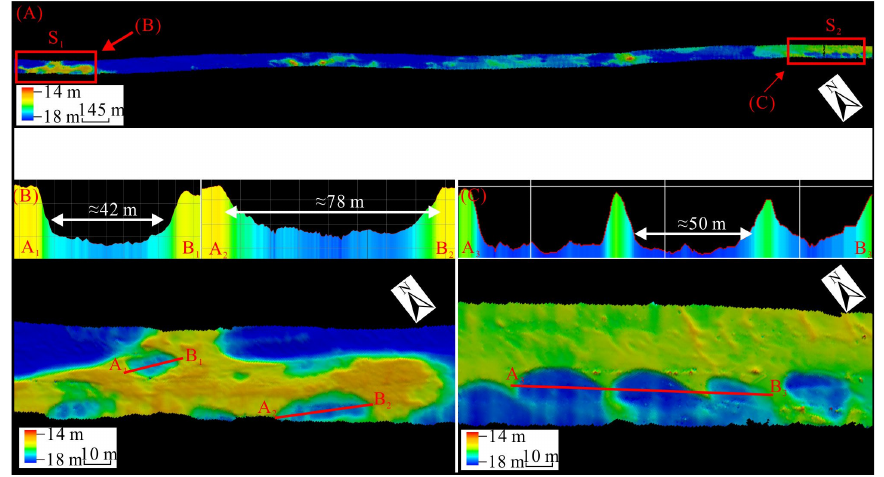
Figure 7. Diagram of the sand mining in the SC of the Yangtze River Estuary. ( A ) The distribution diagram of the dune in SC. S 1 and S 2 represent the location of the sandpit group (Figure 1C). ( B ) and ( C ) The images of the morphology of sand mining.